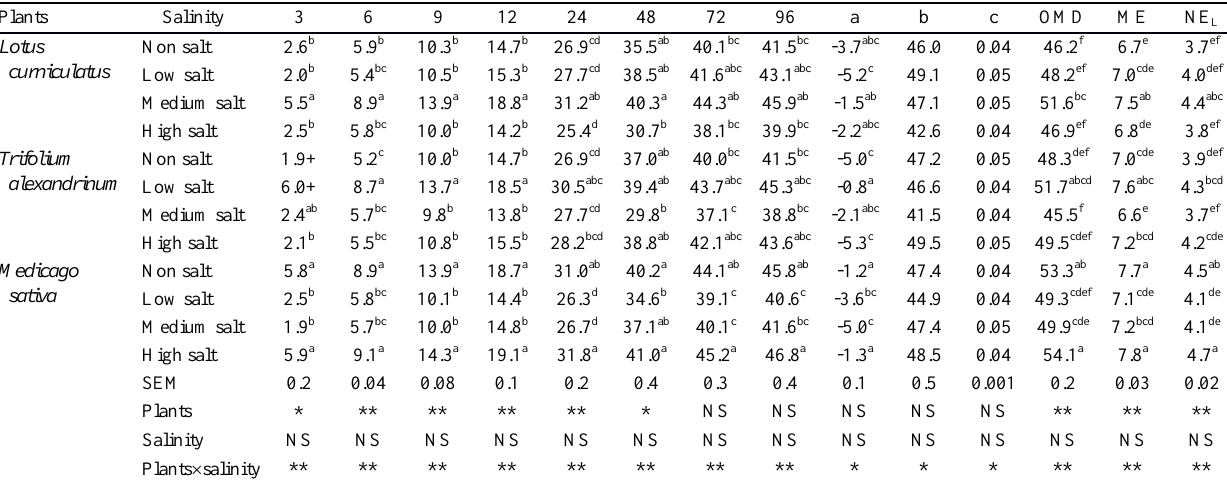
Table 4. In vitro gas production (mL) parameters and ME, NE L and OMD values of Legume species Plants Salinity Lotus curniculatus Low